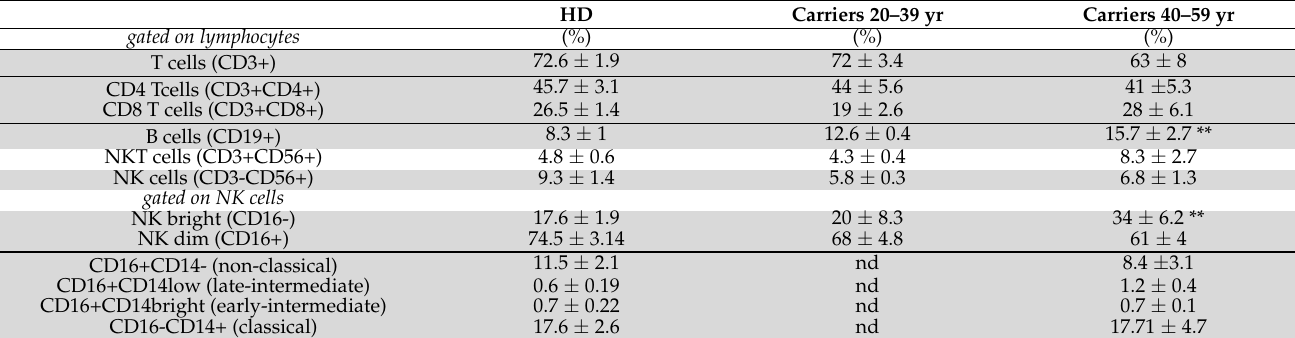
Table 2. Immune phenotype of X-CGD carriers ( n = 12) compared to HDs ( n =